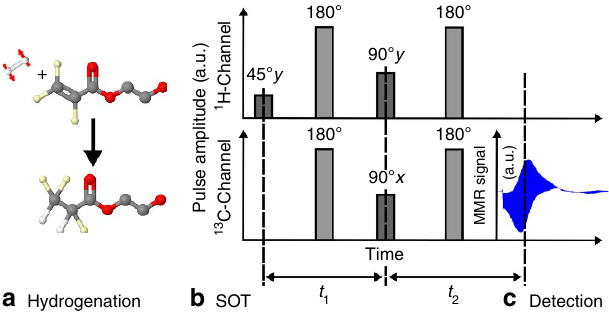
Figure 8 | Schematic view of the HP method: The tracer to-be- hyperpolarized is formed by catalytic addition of p H 2 to an unsaturated precursor molecule ( a , here: hydroxyethyl-acrylate forms the angiography- tracer 27,30 HEP). Next, a pulse sequence is applied subsequently to transfer the spin order (grey bars, here: PH-INEPT þ (ref. 45)), and the enhanced 13 C signal is recorded ( c ). In b , refocusing pulses are shown in light grey. ( c ) Real 13 C-data in the time domain acquired after one HP